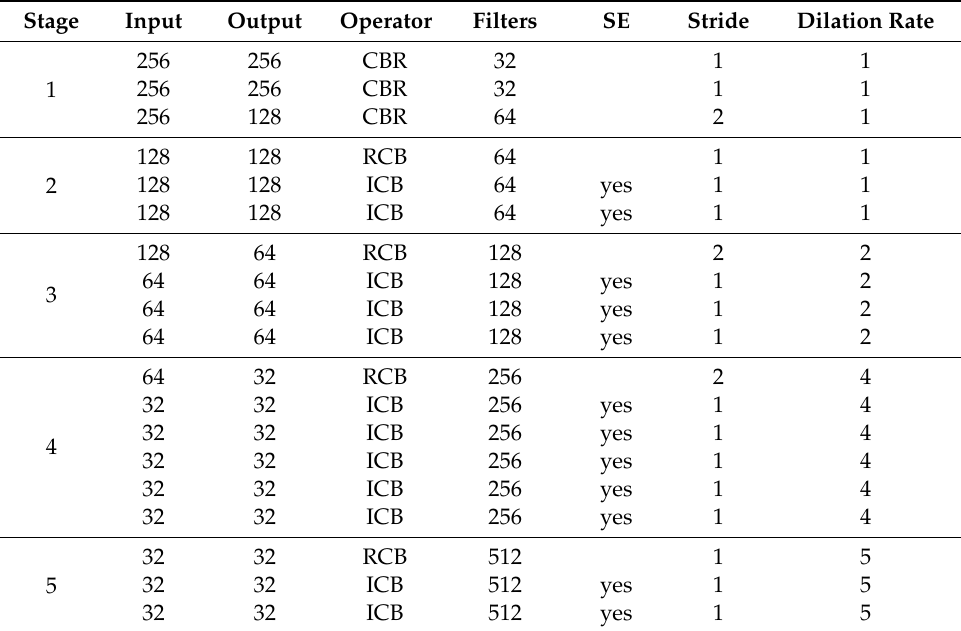
Table 2. Specification of the backbone network.